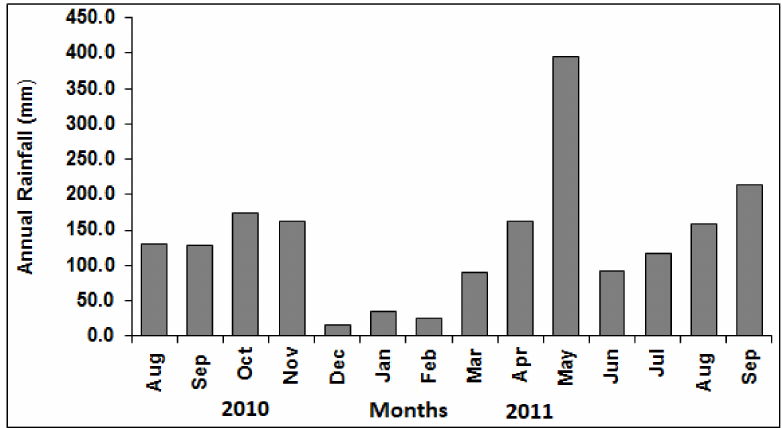
Figure 2. Monthly rainfall for Lajas Puerto Rico, for August 2010 to September 2011.